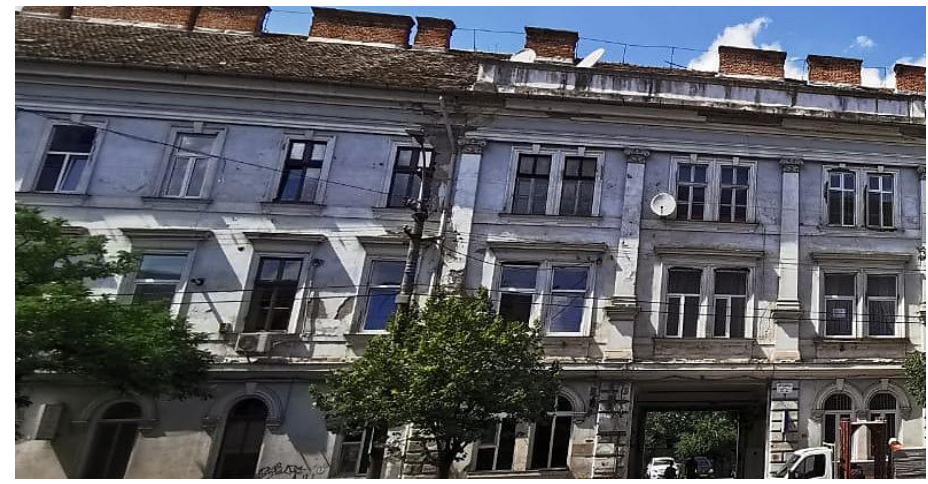
Figure 5. Facade to be rehabilitated.